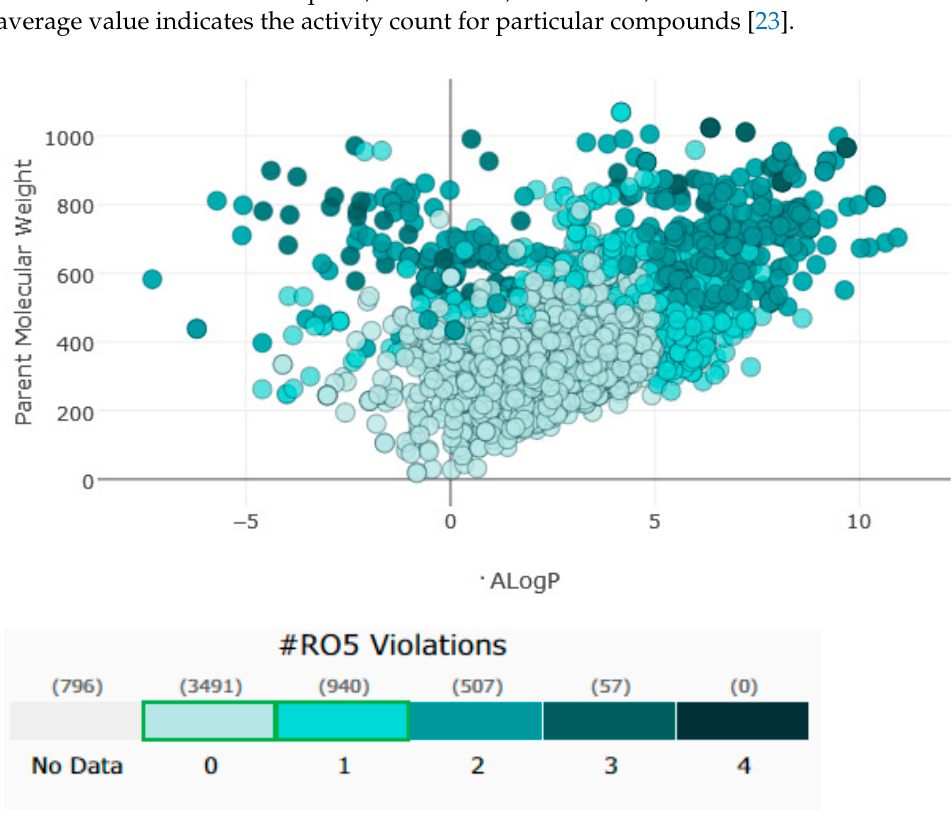
Figure 1. Correlation between molecular weight of nitrogen containing heterocyclic compounds with lop P.